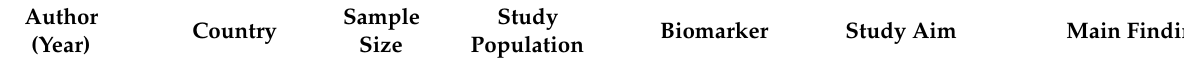
Table 2. Summary of studies conducted in Africa investigating the clinical utility of heart failure